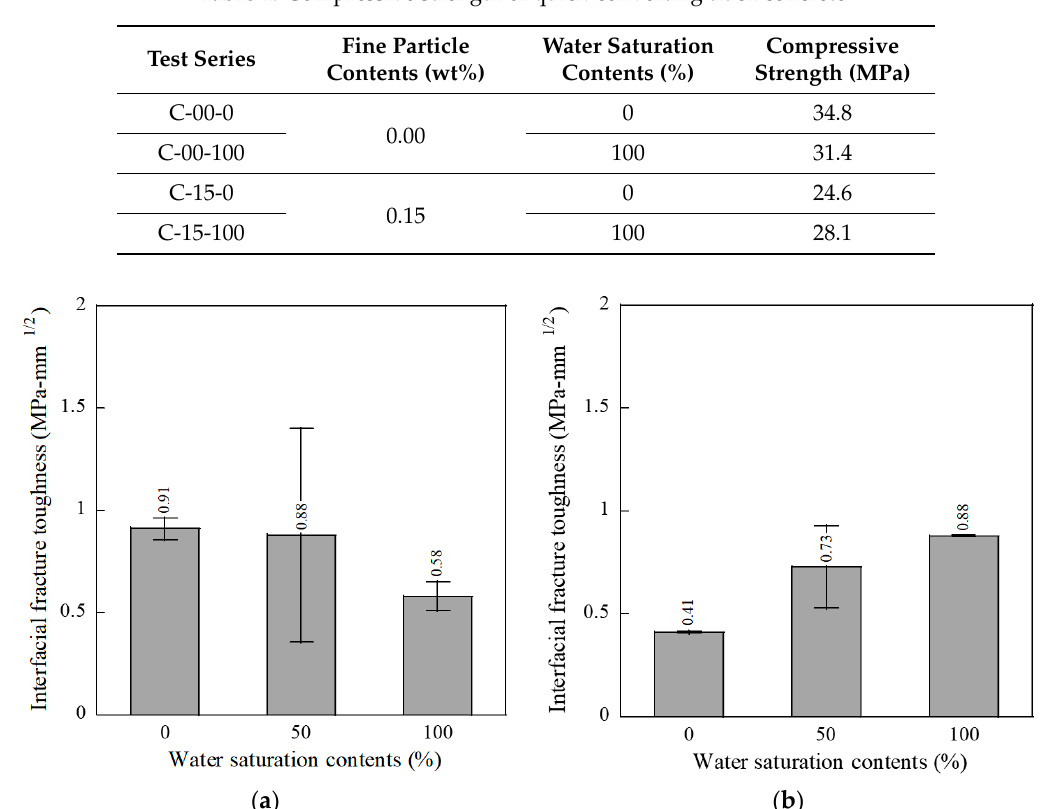
Figure 6. Effects of the water saturation contents on the IFT; ( a ) 0.0 wt% abraded fine particle, ( b ) 0.15 wt% abraded fine particle